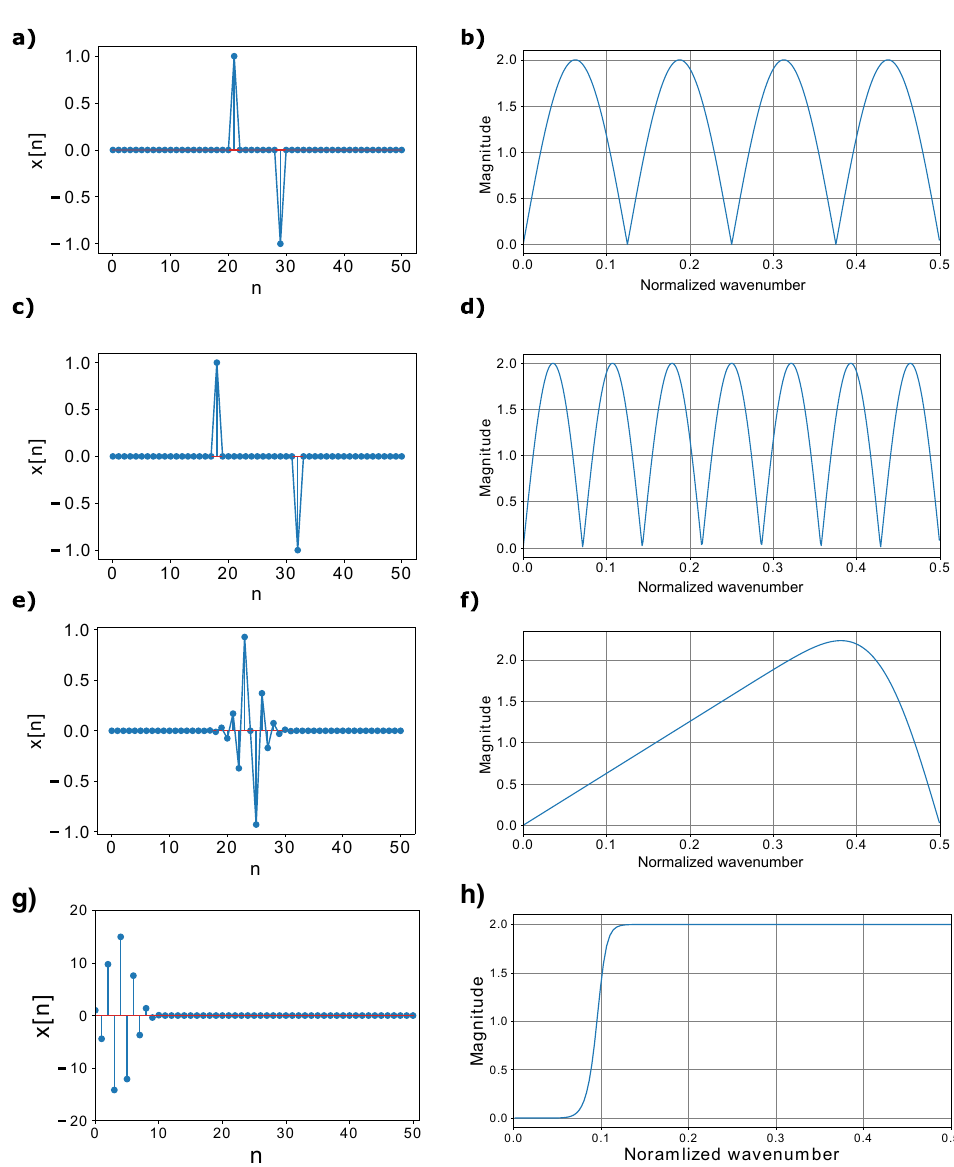
Figure 4. Impulse response filters with their associated magnitude spectra. ( a ) L G = 8-unit FIR filter. ( b ) Magnitude spectrum of the filter in ( a ). ( c ) L G = 14-unit FIR filter. ( d ) Magnitude spectrum of the filter in ( c ). ( e ) 12th-order FD first-derivative FIR approximation. ( f ) Magnitude spectrum of the filter in ( e ). ( g ) Filter coefficient of high-pass Butterworth IIR filter. ( h ) Corresponding magnitude spectrum of the filter in ( g